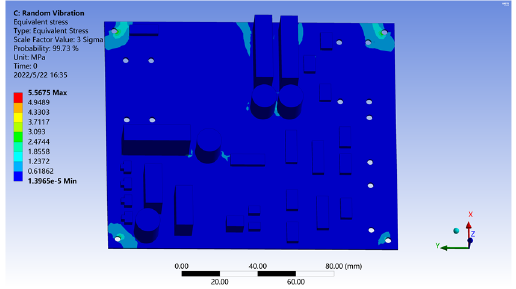
Figure 11. PCB equivalent stress results under roadside excitation.